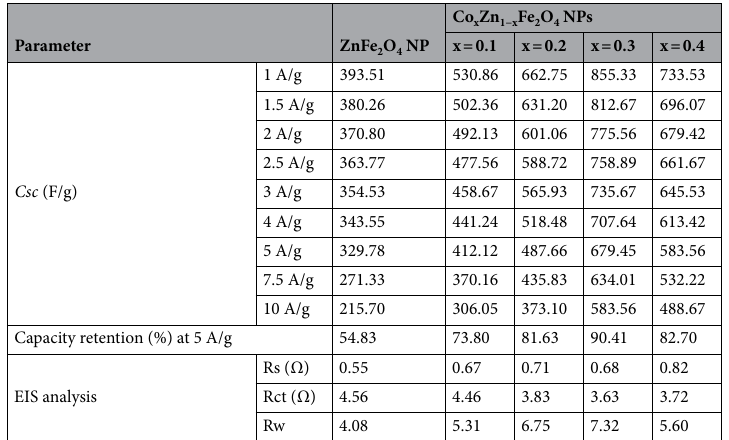
Table 2. Specific capacitance at various current densities, capacity retention after 1000 GCD cycle testing at 5 A/g and EIS analysis of Co x Zn 1−x Fe 2 O 4 (x = 0.0–0.4) NPs electrodes.